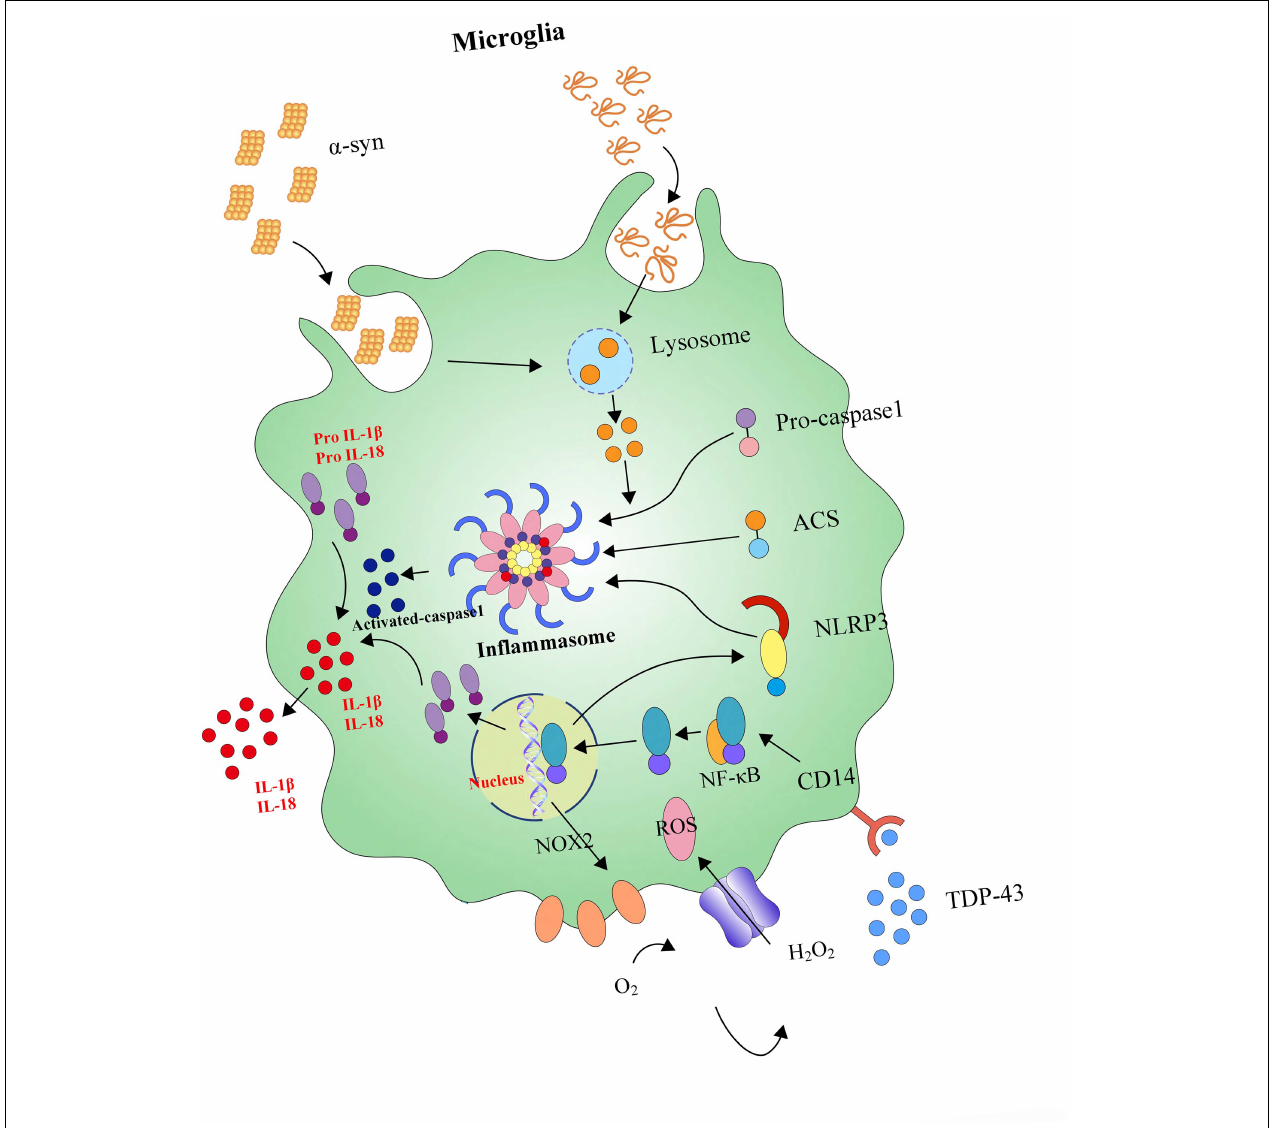
FIGURE 5 | NLRP3 inflammasome activates neuroinflammation. Microglia are equipped with intracellular multi-molecule NLRP3 complexes, which α -syn can activate. NLRP3 inflammasomes could trigger the maturation of IL-1 β and IL-18. High levels of IL-1 β and IL-18 secretion enhances neuronal loss.